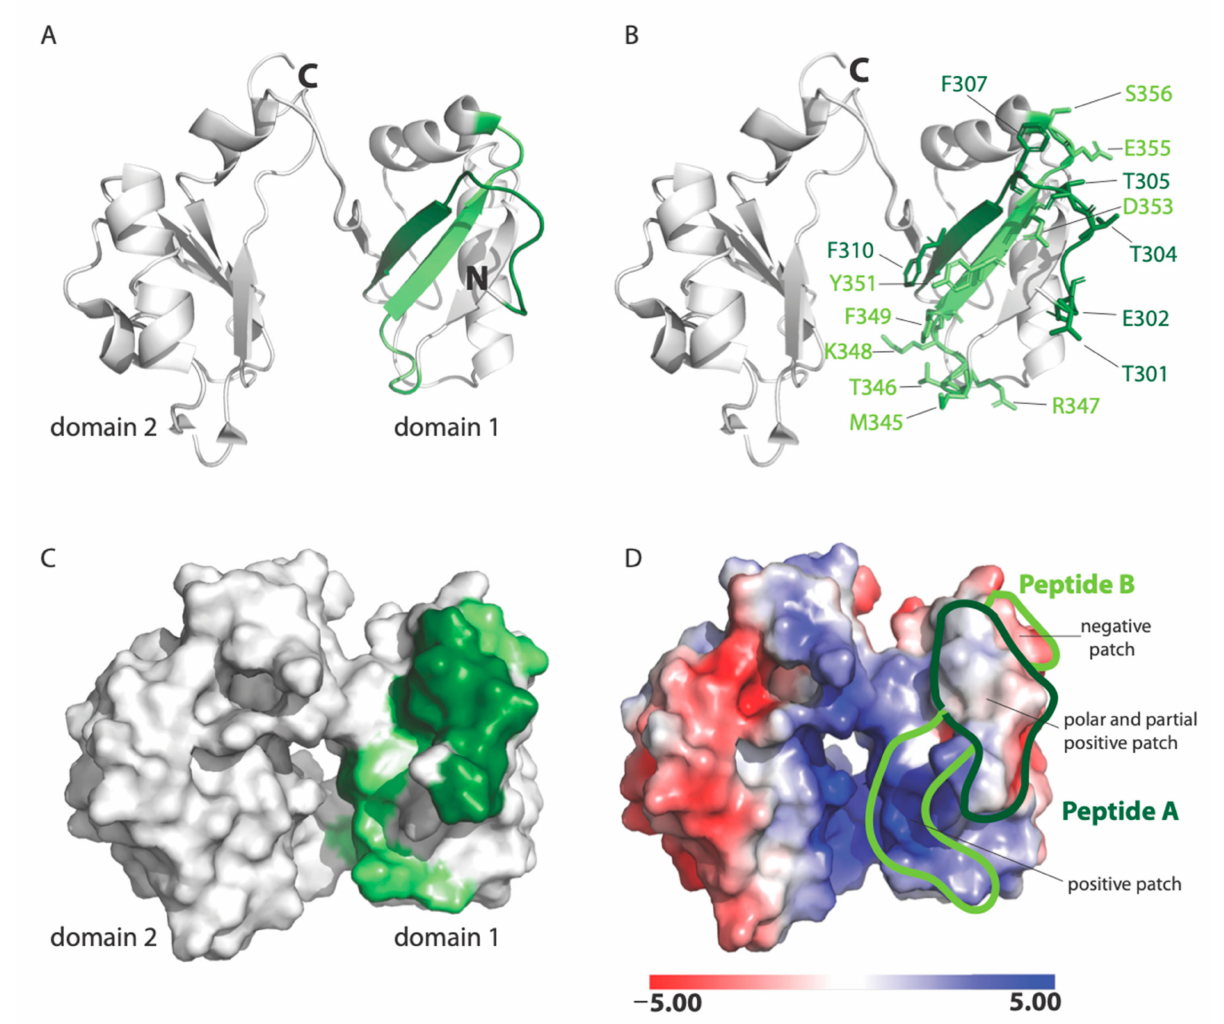
Figure 7. NMR solution structure of human nucleolin, RBD1,2 (PDB code: 2KRR): ( A ) Ribbon-structure representation showing peptide A in dark green and peptide B in light green. Note that the peptides are anti-parallel and are part of a β -sheet; ( B ) surface-exposed residues in peptides A and B are shown in stick format; ( C ) a surface representation of RBD1,2. Peptides A and B are colored in dark and light green, respectively; ( D ) The electrostatic potential representation of RBD1,2. Electrostatic potential units are in